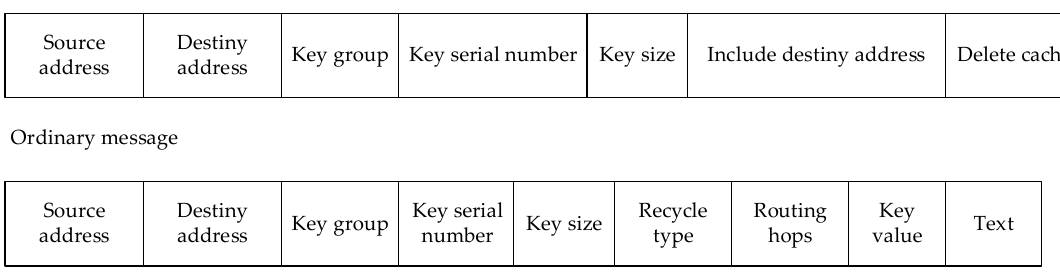
Figure 6. QKP communication message format ： broadcast message format and ordinary message format.